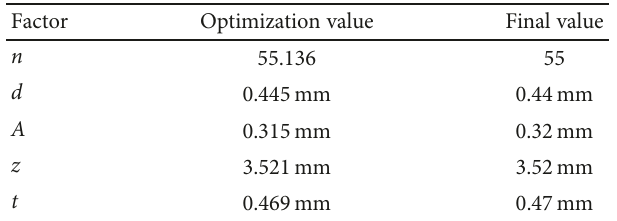
Table 11: Performance comparison of the new type of solar panel between calculation and